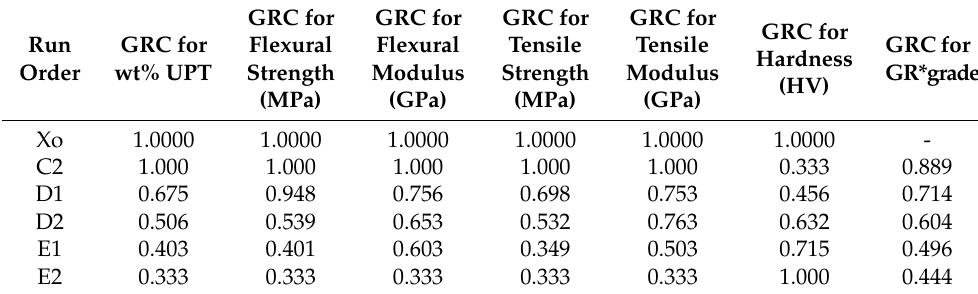
Table 5. Results of GRC and for GR*grade for hybrid